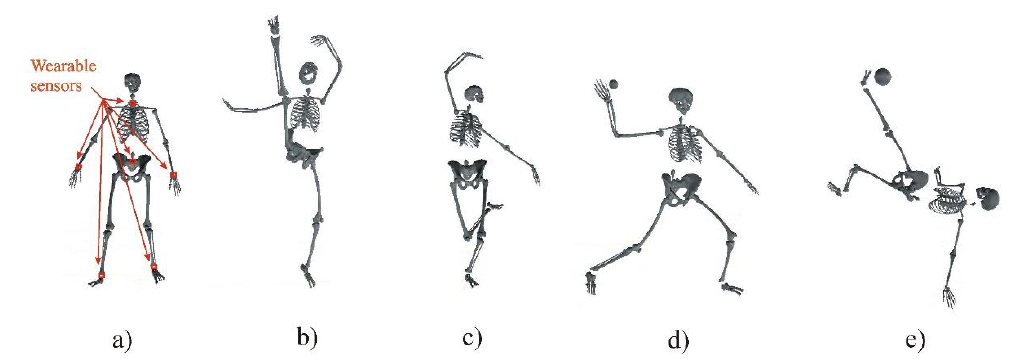
Figure 2. The two-chain model of human motor-skills. ( a ) The possible locations of the six wearables for human motor-skills’ tracking; ( b ) A ballet skill; ( c ) A Indian dance skill; ( d ) Baseball pitch; and, ( e ) Bicycle kick in soccer (the three-dimensional (3D) motion data was generated in Shan’s Biomechanics Lab).